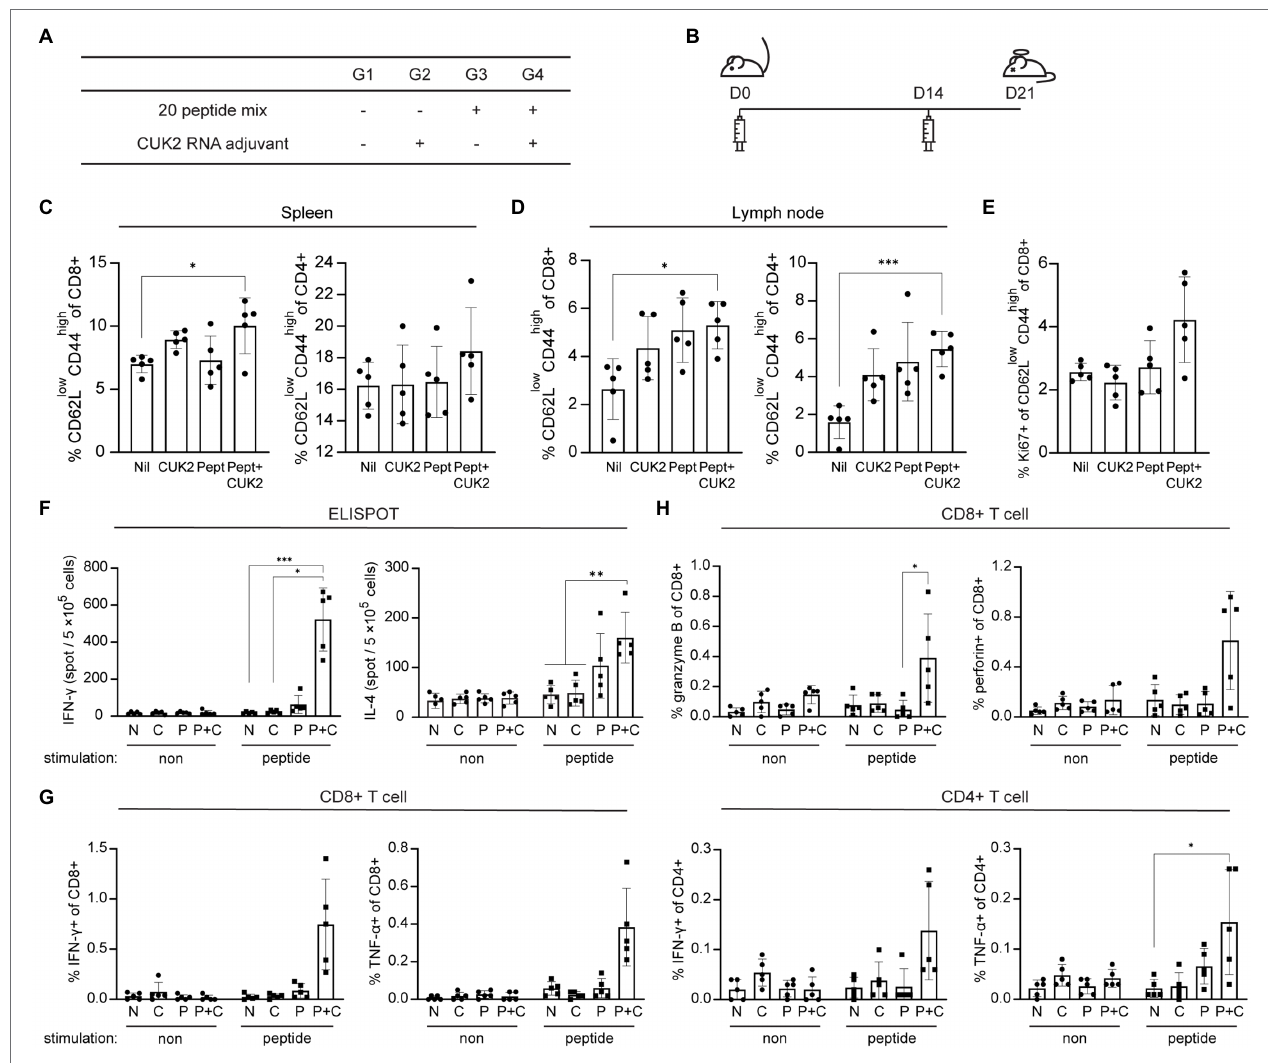
FIGURE 2 | Analysis of T cell activation after immunization with the SARS-CoV-2 20-peptide mixture and CUK2 RNA adjuvant. (A) Overview of the experimental groups. (B) Immunization schedule of mice. C57BL/6 mice were immunized twice at 2-week intervals with the 20 SARS-CoV-2 peptides mixture + CUK2 RNA adjuvant and killed 1 week after the final immunization. (C,D) The percentages of effector memory type of CD4+ and CD8 + T cells (CD62L low CD44 high ) in the spleen and lymph nodes were analyzed using flow cytometry. (E) The Ki-67+ population in CD8 + effector memory T cells in the spleen was assessed using flow cytometry. (F) The numbers of 20 peptide-specific interferon- γ (IFN- γ )- and interleukin (IL)-4-producing cells in splenocytes were measured using enzyme-linked immunospot (ELISPOT; n = 5 mice). (G) IFN- γ - and tumor necrosis factor- α (TNF- α )-producing CD8 + and CD4 + T cells in the spleen were examined using flow cytometry. (H) Granzyme B- and perforin-producing CD8 + T cells in the spleen were analyzed using flow cytometry. Data represent mean ± SD. * p ≤ 0.05; ** p ≤ 0.01; and *** p ≤